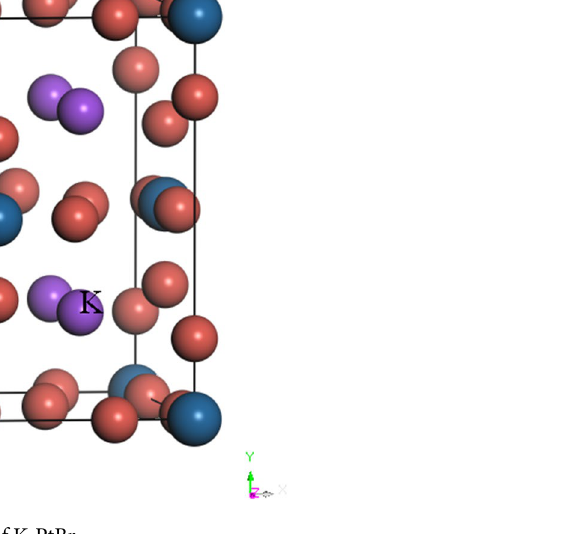
Figure 1. The crystal structure of K 2 PtBr 6